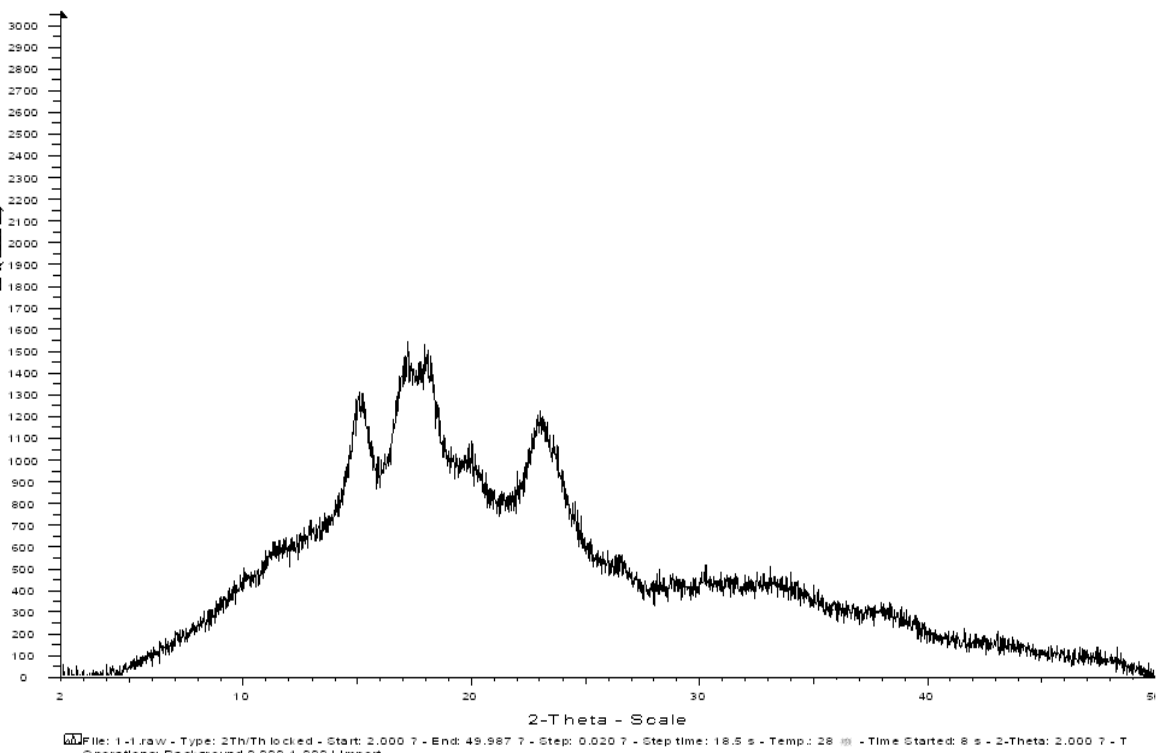
Figure 4. XRD profiles of unfractionated starch and isolated A- granules and B-granules.